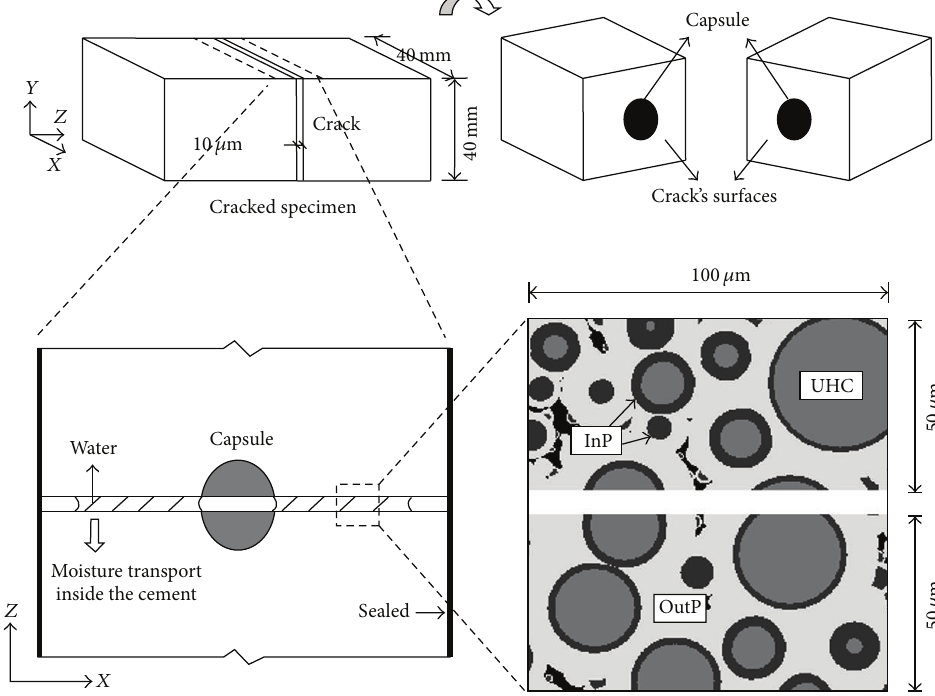
Figure 3: Schematic diagram of modeling system for further hydration (InP represents inner products, OutP represents outer products, and UHC represents unhydrated cement particles) [31].